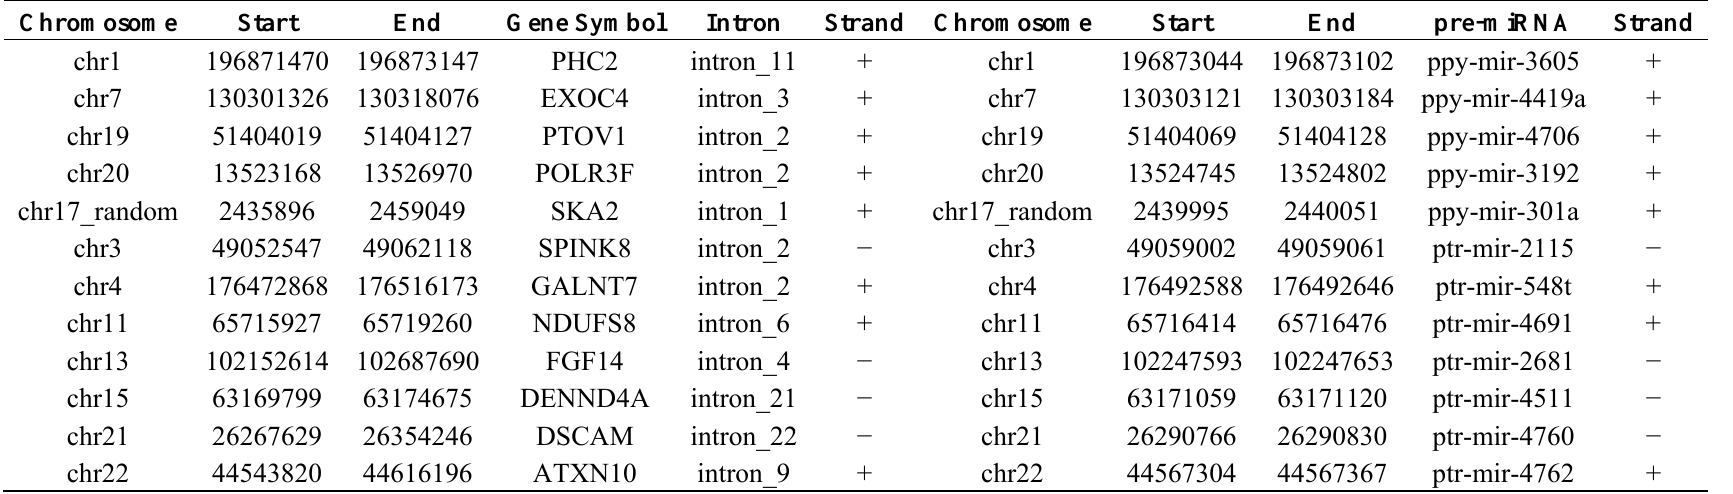
Table 2. Some validated miRNAs and their host genes in chimpanzee and orangutan. The validated miRNAs which targets are potentially involved in nervous system are located in protein-coding genes. Moreover, the number that follows “intron_” in this table means the miRNA location in which intron of the corresponding protein-coding gene. These coordinates of protein-coding genes and miRNAs of chimpanzee were derived from panTro4 assembly instead of panTro3. Moreover, all the sequence information of chimpanzee in this study was derived from panTro3 assembly if not explained